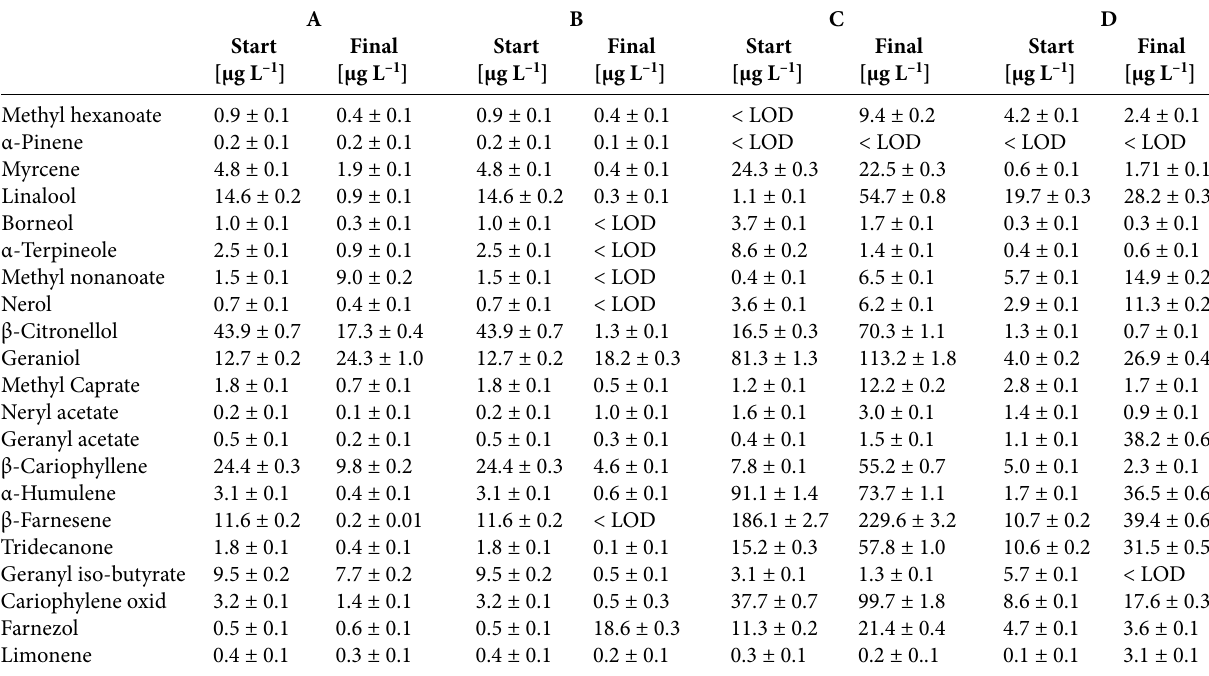
Table 4. Concentrations of hop essential oil components in beer types A-D (LOD = 0.1 µg L –1